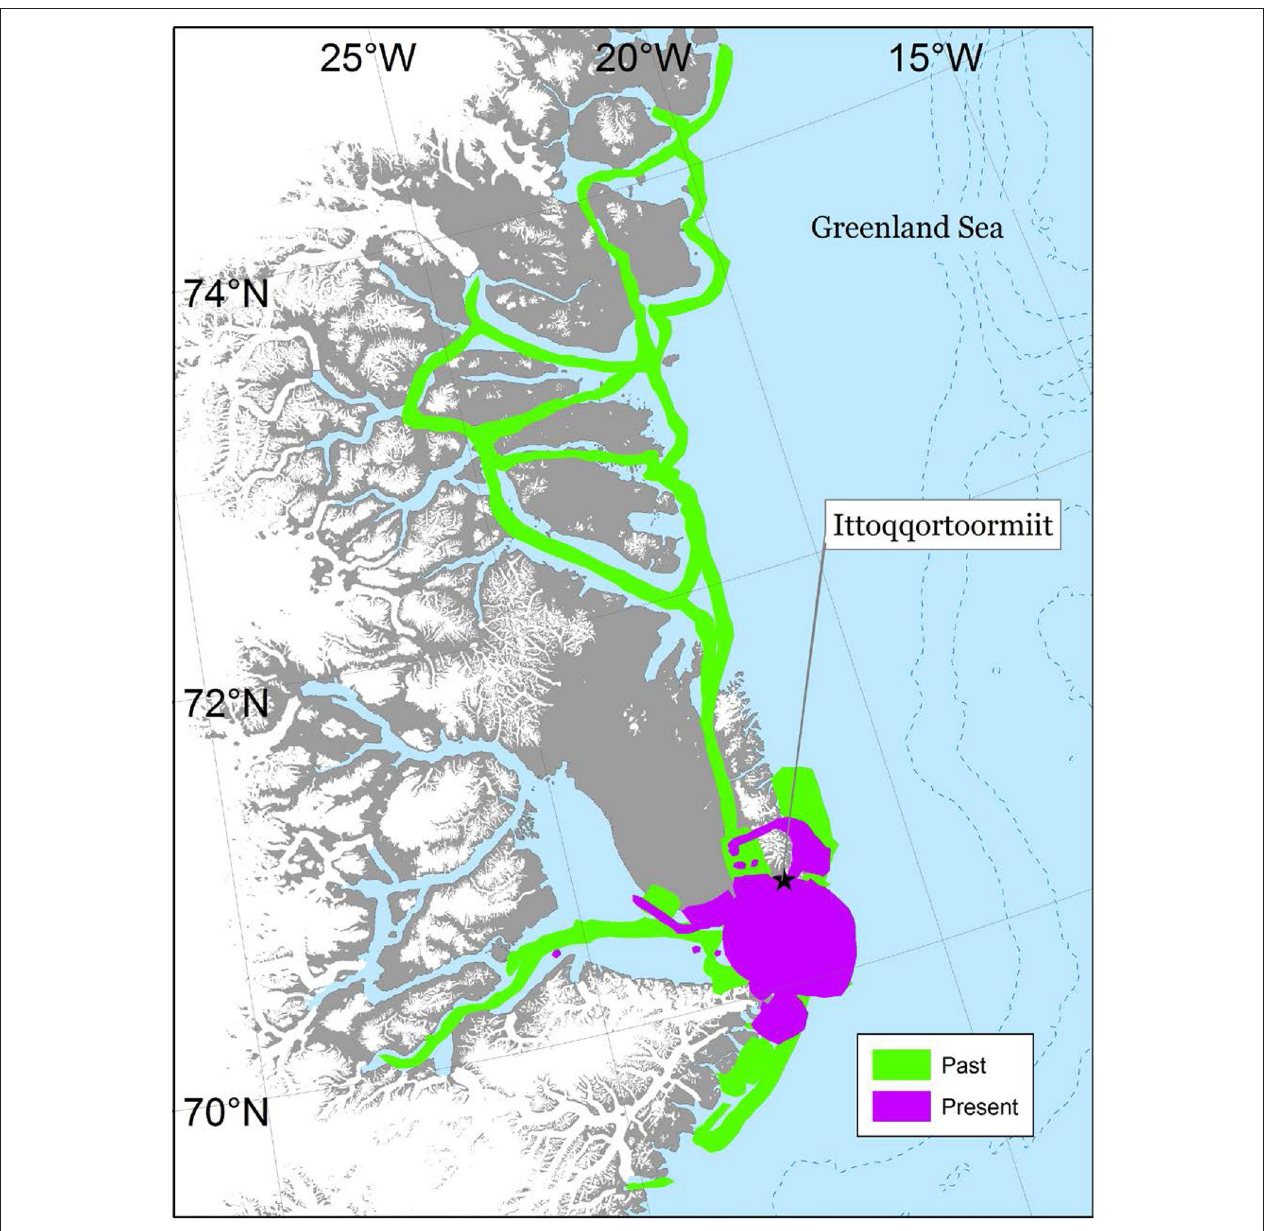
FIGURE 4 | Map of Ittoqqortoormiit responses ( n = 8) showing where they used to hunt bears 10–15 years ago, (“past” in green), and where they hunt bears now (“present” in purple).